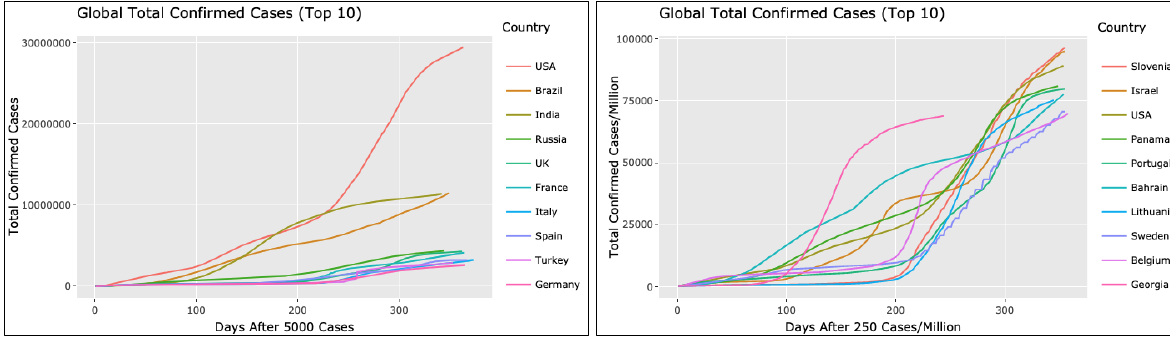
Figure 8. Before (Left) and After (Right) Population